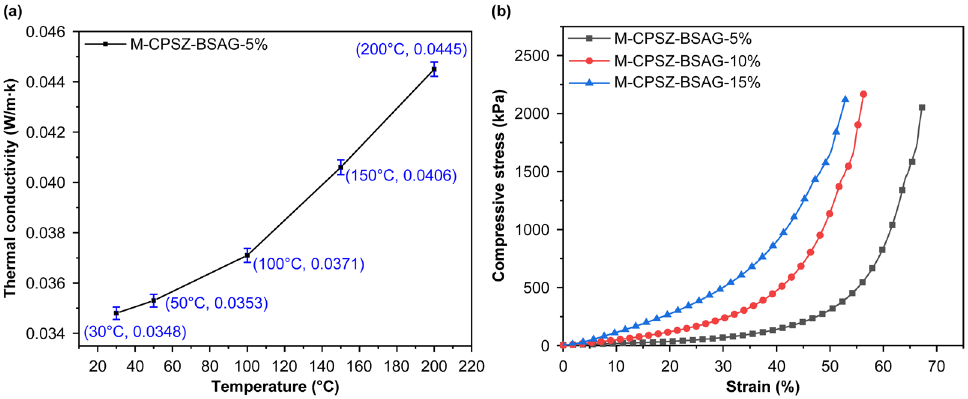
Figure 9. ( a ) Thermal conductivity of M-PSZ-BSAG-5% at different environmental temperatures, and ( b ) compressive stress–strain curves of composites impregnated with different precursor concentra- tions.